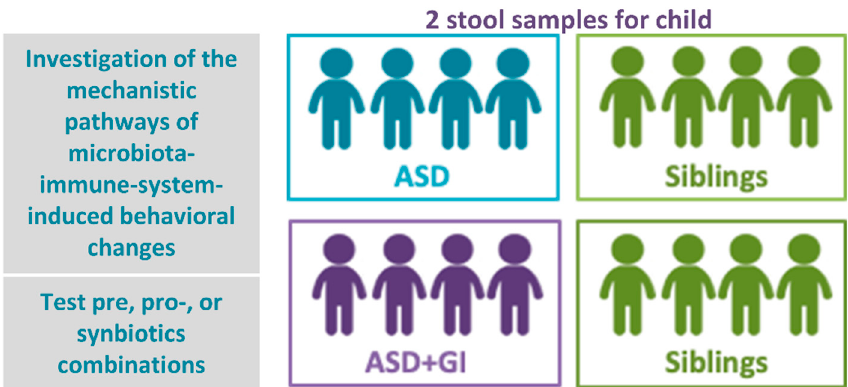
Figure 2. Preclinical studies—development of humanized mouse models by transplanting fecal samples from a well-characterized ASD diagnosed proband (and sibling controls). Four groups of children, each with 4 children, recruited in one center in Europe (Italy): autistic with no GI problems, autistic with GI problems, controls without or with GI problems. Ongoing.